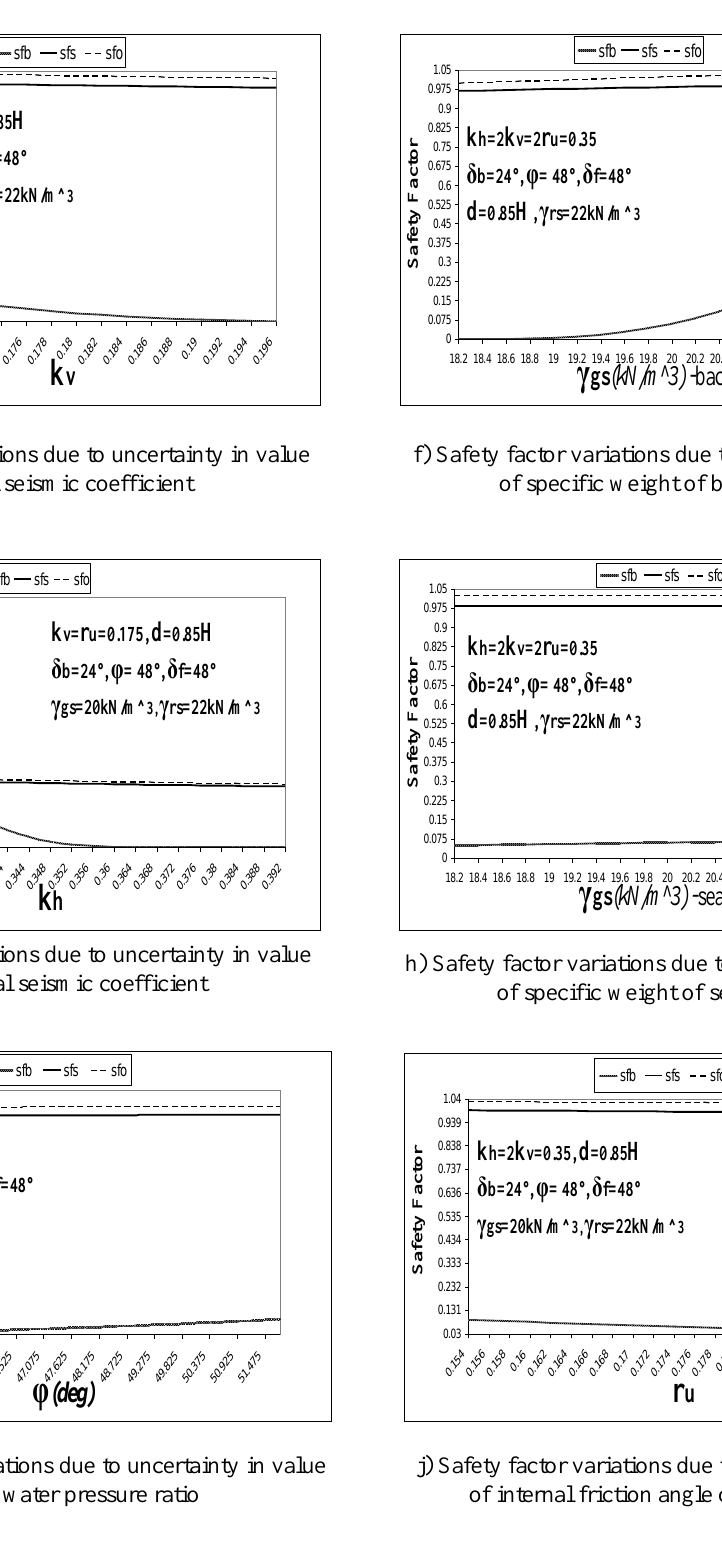
Fig. 3. Safety factor variations due to uncertain design